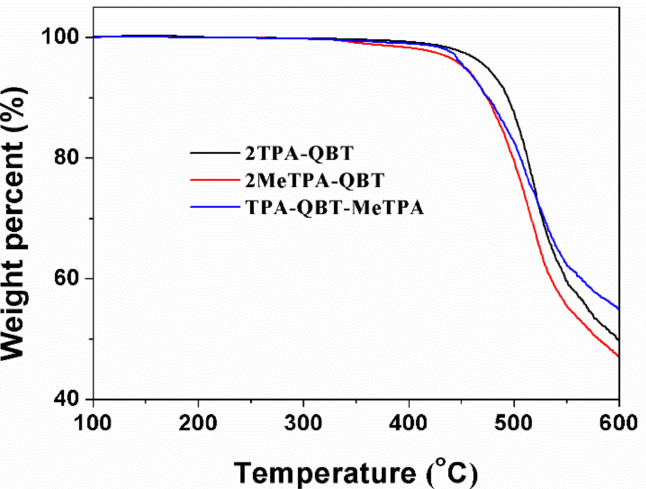
Figure 2. Thermogravimetric analysis curves for 2TPA-QBT , 2MeTPA-QBT and TPA-QBT-MeTPA